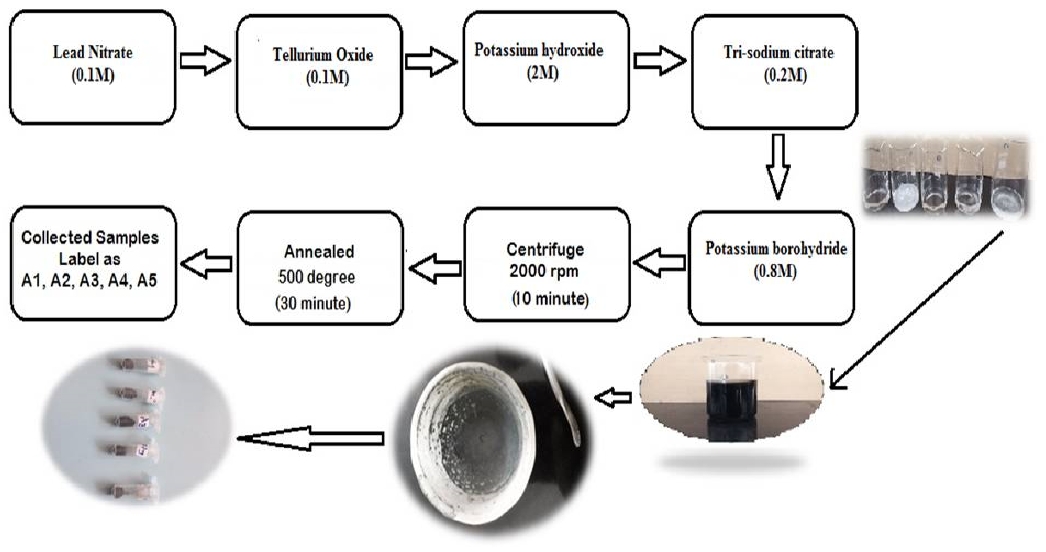
Figure 1. Step by step procedure for the synthesis of PbTe powder.